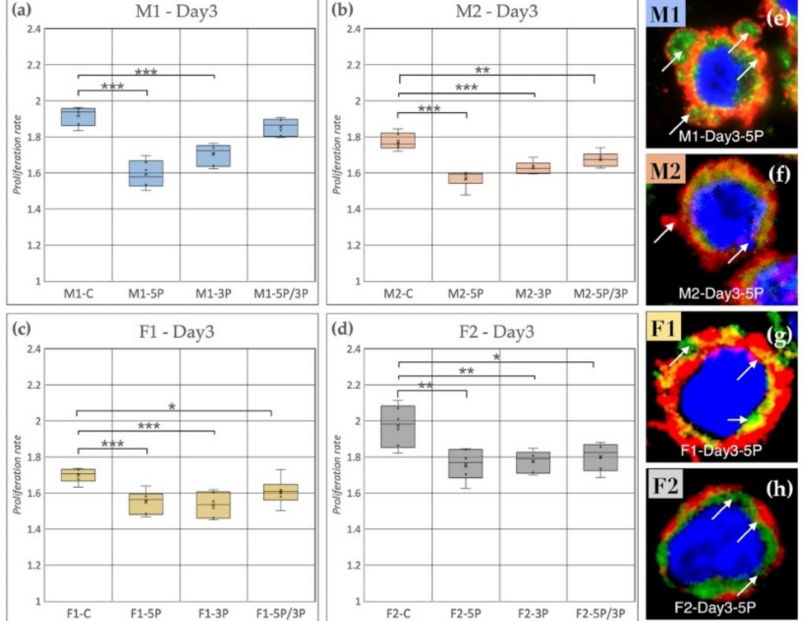
Figure 8. ( a ) Comparison of the proliferation rate of M1 ( a ), M2 ( b ) (ZZ genotype) and F1 ( c ), F2 ( d ) (ZW genotype) PGC lines on Day 3. C: non-inhibited, 5P: gga-miR-302b-5P inhibition, 3P: gga-miR-302b-3P inhibition, 5P/3P: gga-miR-302b-5P and gga-miR-302b-3P inhibition. ( e – h ) Im- munostaining of M1, M2, F1 and F2 PGCs after three days of cultivation in anti-gga-miR-302b-5P inhibitor-containing medium. The immunostaining was achieved with SSEA-1 (red), CVH (green) and TO-PRO™-3 for nuclear staining (blue). Arrows show the blebbings on the cell surface ( p < 0.05 *, p < 0.01 **, p < 0.001